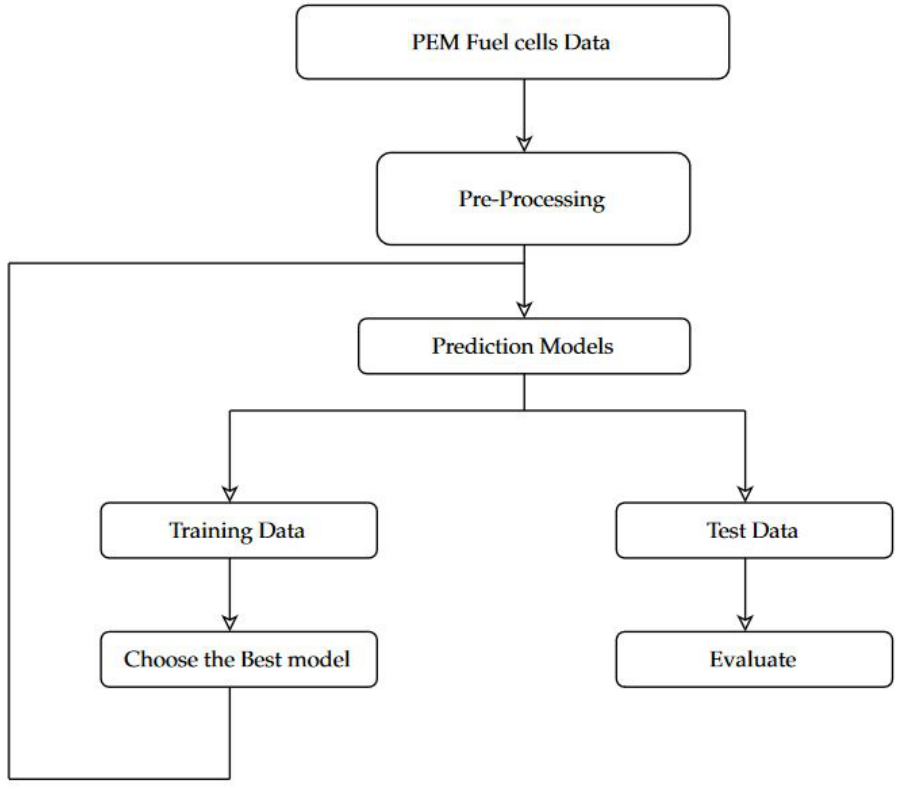
Figure 1. Architecture of proposed